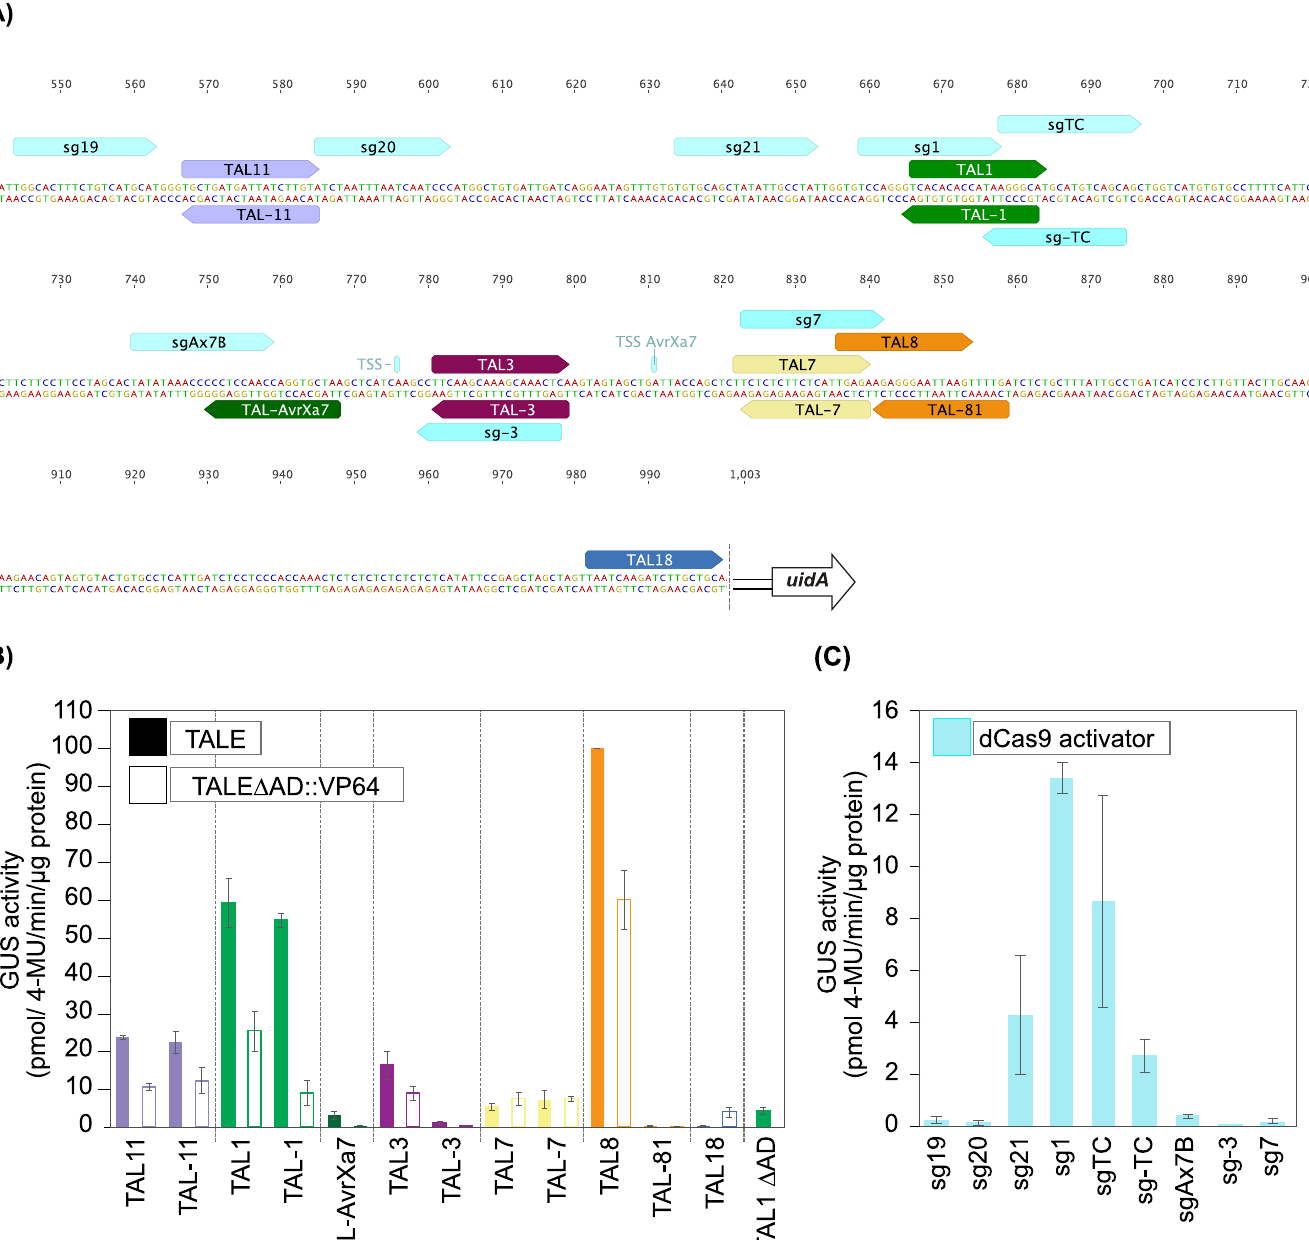
PLOS ONE | https://doi.org/10.1371/journal.pone.0173580 March 16,